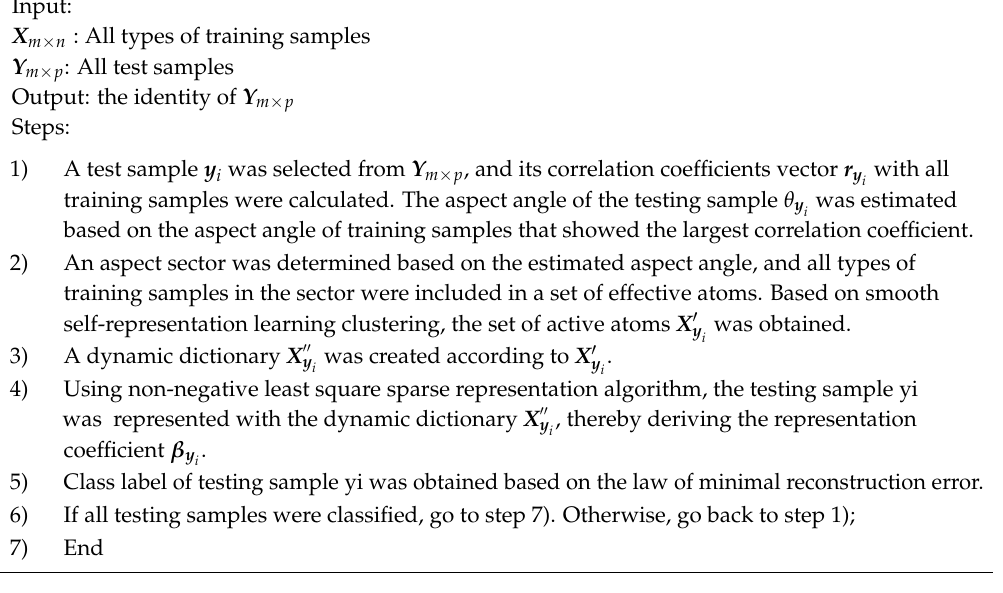
Algorithm 1: ADNNLS sparse representation for microwave image recognition